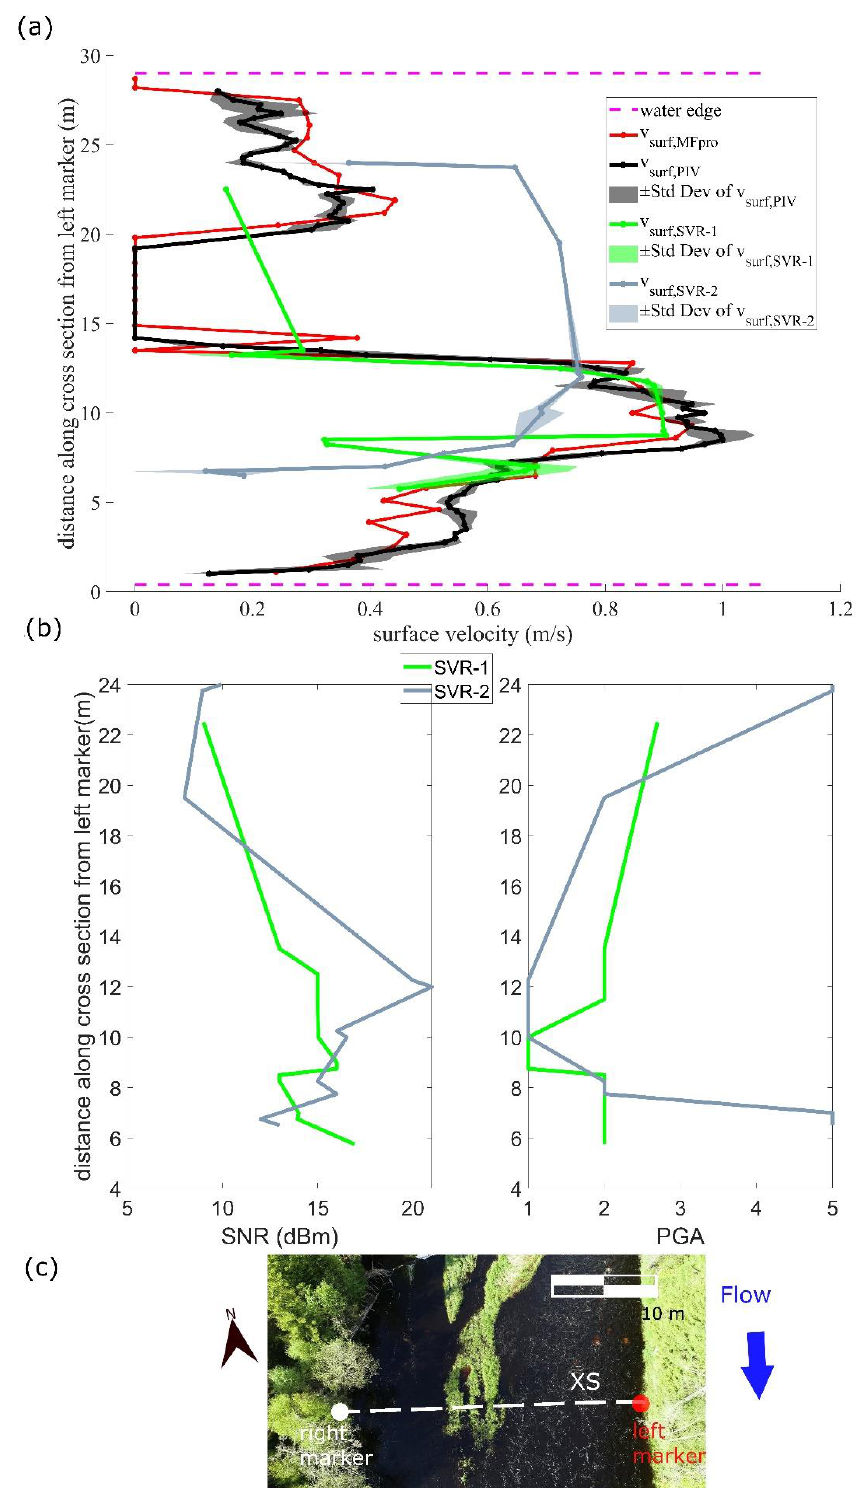
Figure 7. Kilan XS. ( a ) surface velocity comparing: MFpro measurements of surface velocity (v surf,MFpro ), UAS-borne PIV measurements (v surf,PIV ) and two UAS-borne SVR (v surf,SVR-1 , v surf,SVR-2 , all of which pointing upstream) surveys. SVR and PIV are represented with shaded regions to present standard deviation (±Std Dev). ( b ) Comparison of two quality indicators (SNR and PGA) for the SVR surveys. ( c ) UAS-borne video frame of the XS (North arrow, approximate flow direction and approximate scale are also